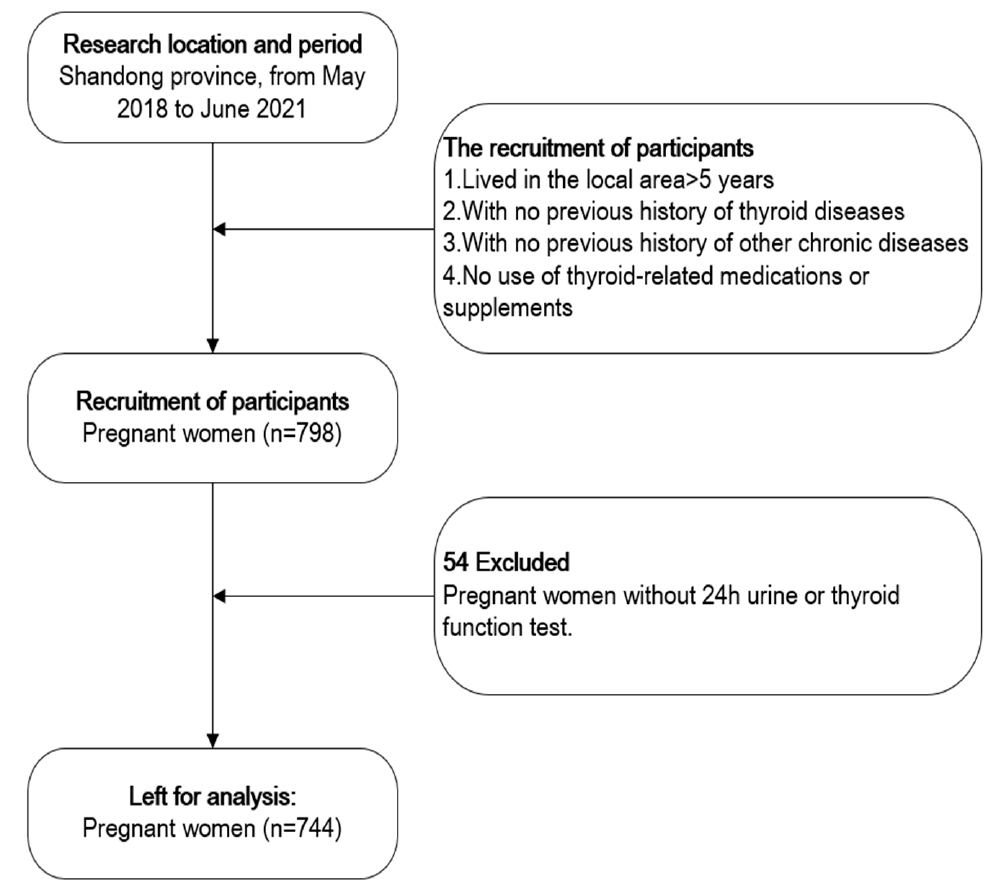
Figure 1. Flow chart of participant screening process.